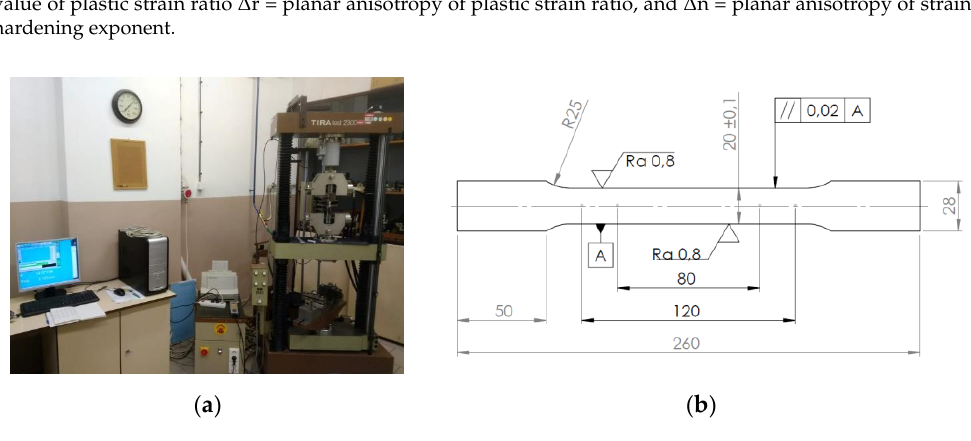
Figure 1. The uniaxial tensile test: Testing machine TIRAtest 2300 ( a ); Specimen dimensions for the test (mm) ( b ).